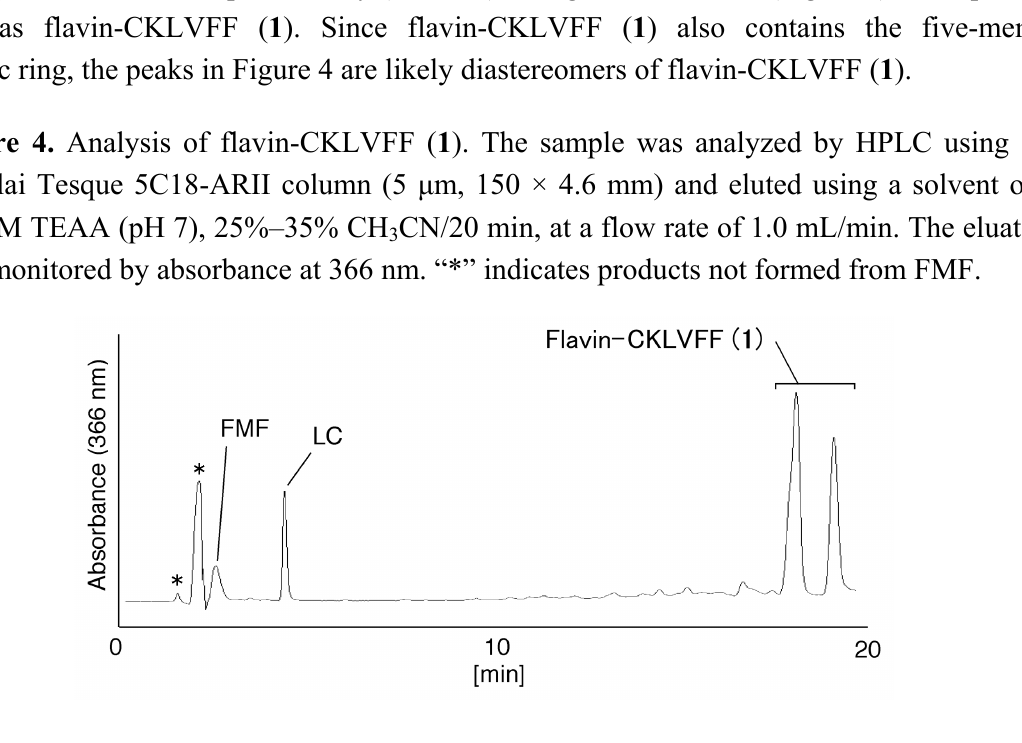
Figure 5. The UV-vis spectrum of flavin-CKLVFF ( 1 ). The UV-vis spectra of the